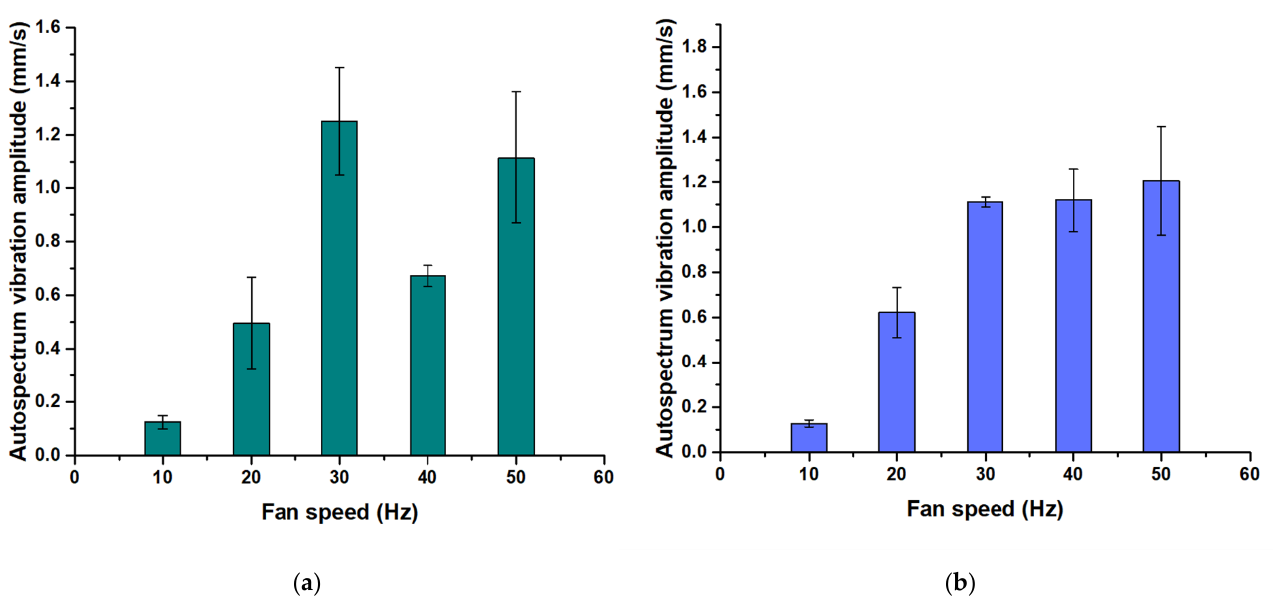
Figure 14. The vibration amplitude versus the wind tunnel fan frequency ( a ) in the inlet test section and ( b ) exit test section.